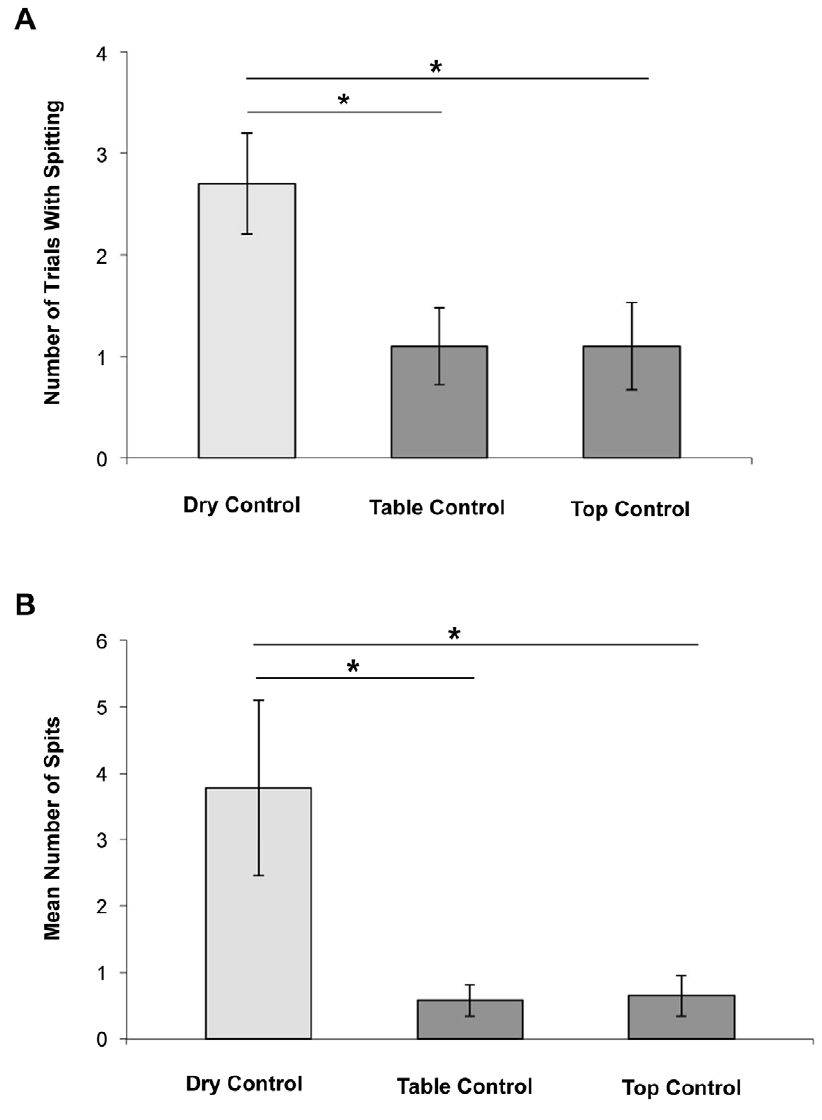
Figure 2. Spitting behavior for each of the three control conditions in Experiment 2. 2a) Mean number of trials in which subjects spat into the tube; 2b) Mean number of water spits that subjects added in total. * p , .05. Error bars depict the standard errors of the means.